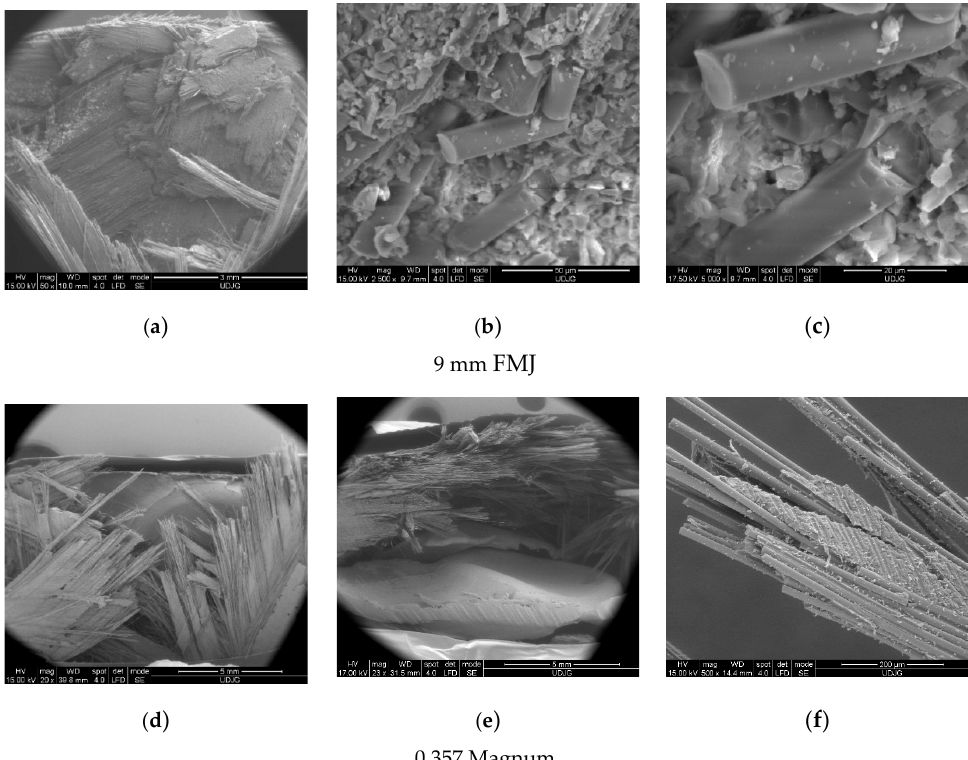
Figure 12. SEM images of the panel cross-section: ( a – c ) for 9 mm FMJ, ( d – f ) for .357 Magnum.